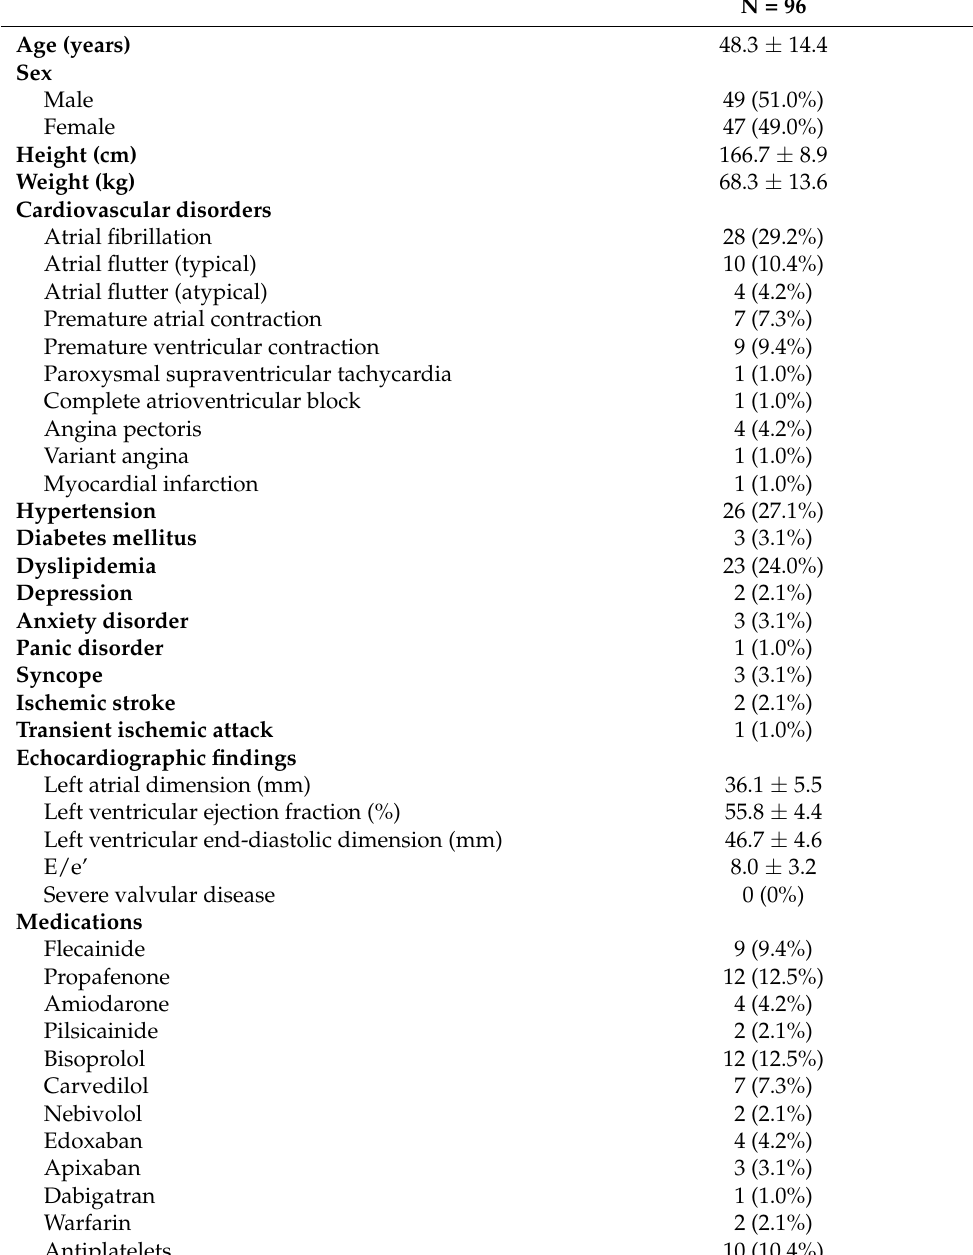
Table 1. Baseline